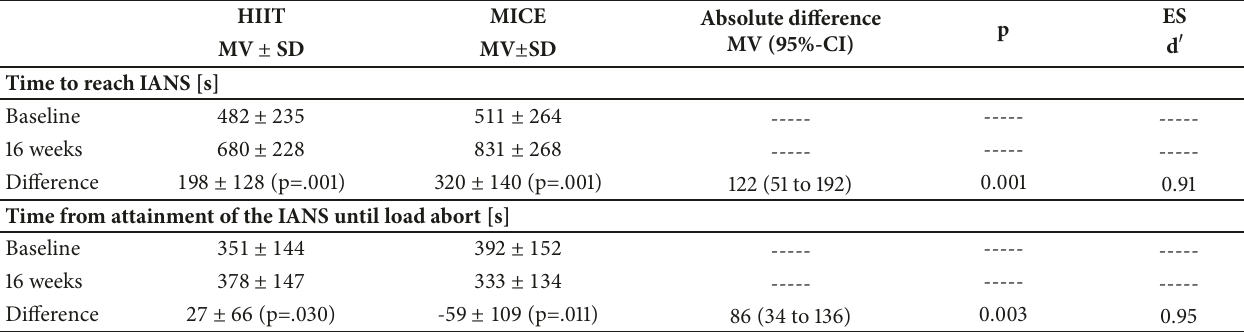
Table 3: Results for the study endpoints. Mean values, standard deviations, and mean difference between the groups with 95% confidence interval, as well as significance values of the intergroup comparison and corresponding effect size (ES). Numerical value in parentheses: Significance value of the change within the groups between base and final (16-week